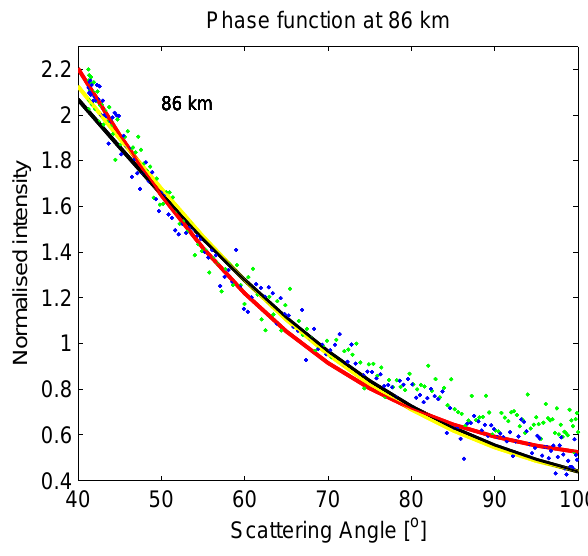
Fig. 5. Scattering phase function for the layer centred at 86 km compared to theoretical descriptions. The lines show the theoretical phase function for different ice particle distributions. The black line is the same as in the top panel of Fig. 4, i.e. the phase function of a monodisperse distribution of spheres of 51nm radius. The yellow line represents the the phase function for a Gaussian distribution of spheres with mean radius r =30nm and σ =14nm. The red line rep- resents the scattering phase function of a monodisperse distribution of non-spherical particles with axis ratio of 1:4 and volume equiva- lent radius r